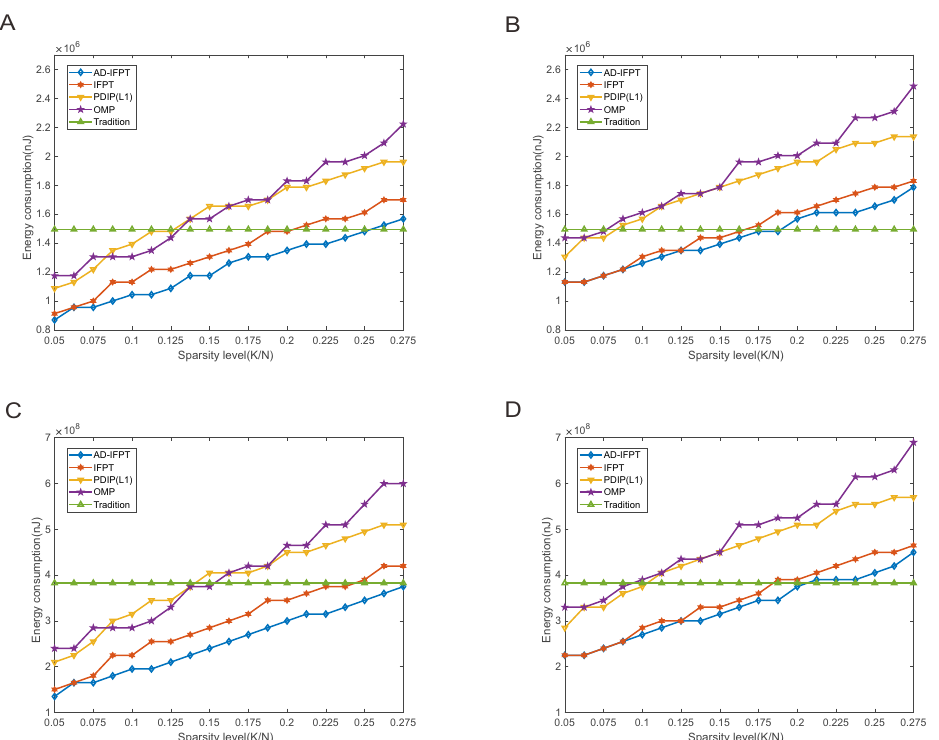
Figure 7. Energy consumption in four cases. ( A ) Analog compressed sensing processing; ( B ) analog compressed sensing with abnormal events; ( C ) compressed data gathering in a multi-hop WSN; ( D ) compressed data gathering in a multi-hop WSN with abnormal